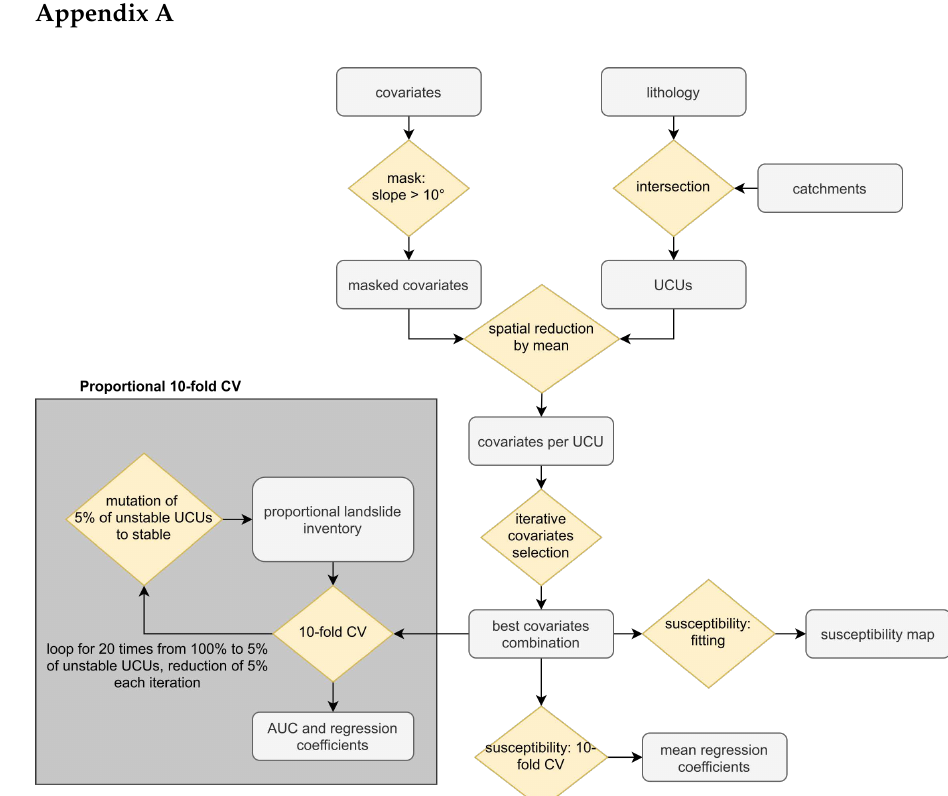
Figure A1. Flow-chart summarizing the analytical protocol we implemented.